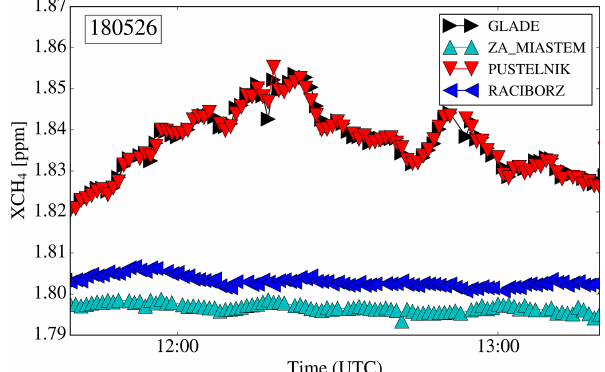
Figure A1. Calibrated XCH 4 measurements from 26 May. The in- struments for The Glade (E) and Pustelnik (S) measured side-by- side at the station Pustelnik. The other two instruments measured at their respective campaign locations. The calibration of The Glade (E) towards the other instruments is based on these